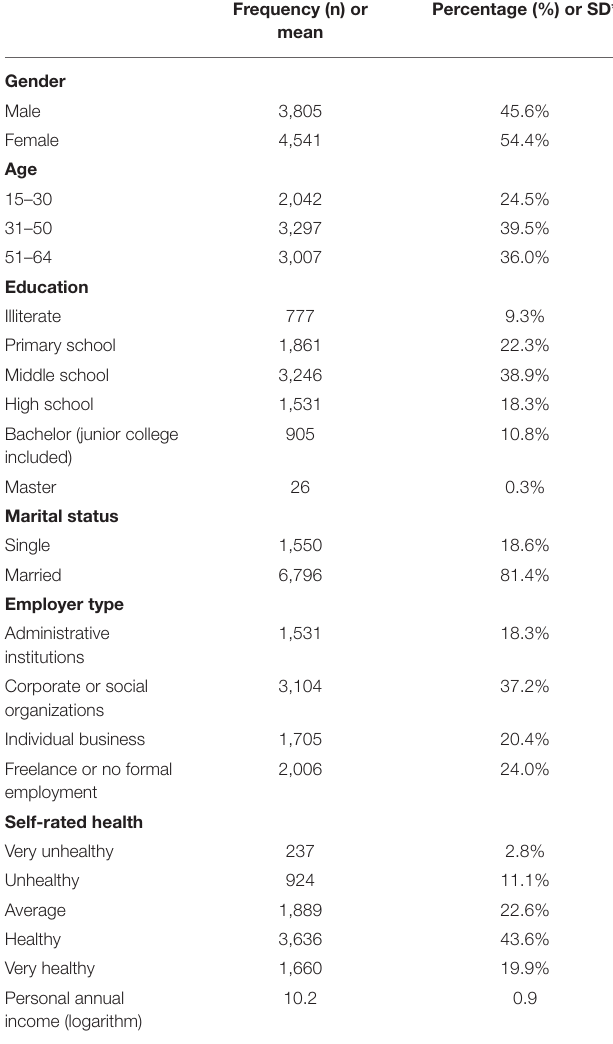
TABLE 1 | Descriptive statistics of variables ( N = 8,346).